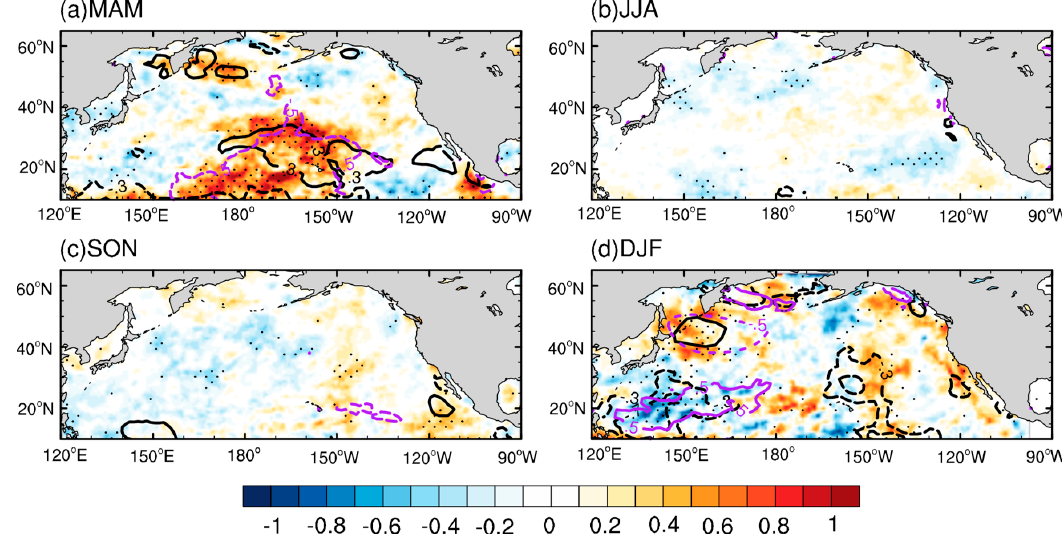
Figure 8. Regression coefficients of interannual LCF (shading; units: %), advT (purple contour; units: K/day), and SHF (black contour; units: W/m2) onto the SPFZ index for ( a ) spring, ( b ) summer, ( c ) autumn, and ( d ) winter. Stippling indicates the 90% confidence level using the t test. Contours indicate statistically significant positive (solid) and negative (dashed) differences at the 90% confidence level based on the t test.